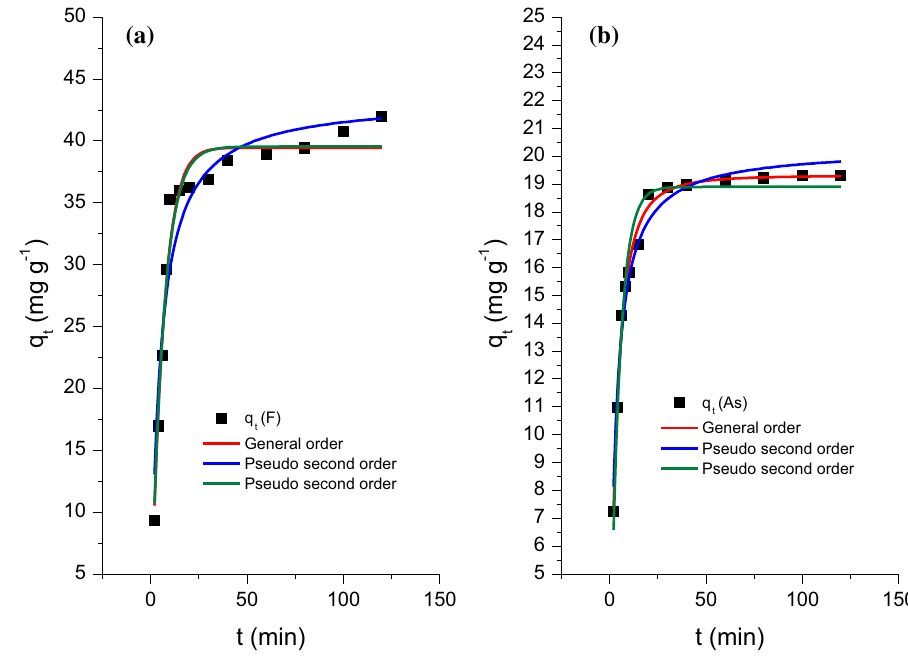
Fig. 5 Fitting of kinetic models to Fe-KWC for adsorption of Fluoride ( a ) and Arsenic ( b